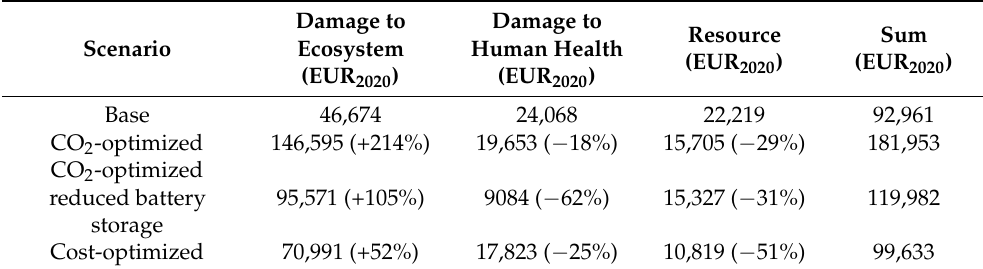
Table 4. Monetary valuation of endpoint-results in the three scenarios in EUR for 2020. The percentage deviation from the actual scenario is shown in